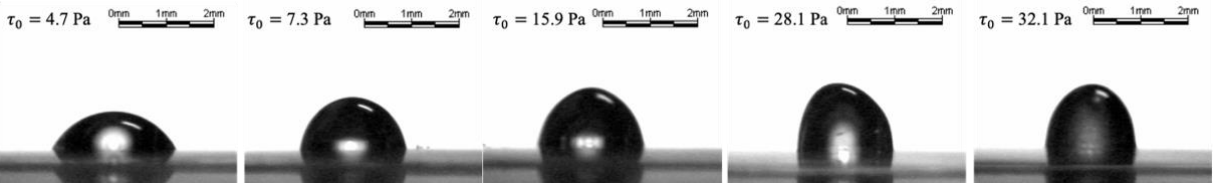
Figure 2. Spreading of gel tears with various yield stresses 𝜏 0 .